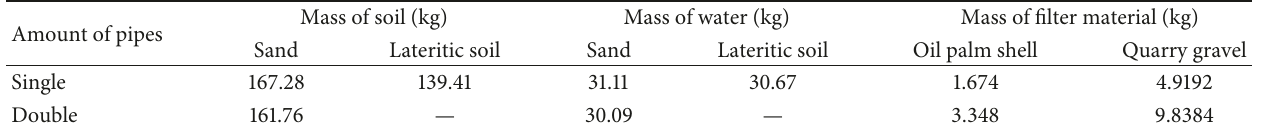
Table 3: Materials used for single- and double-pipe